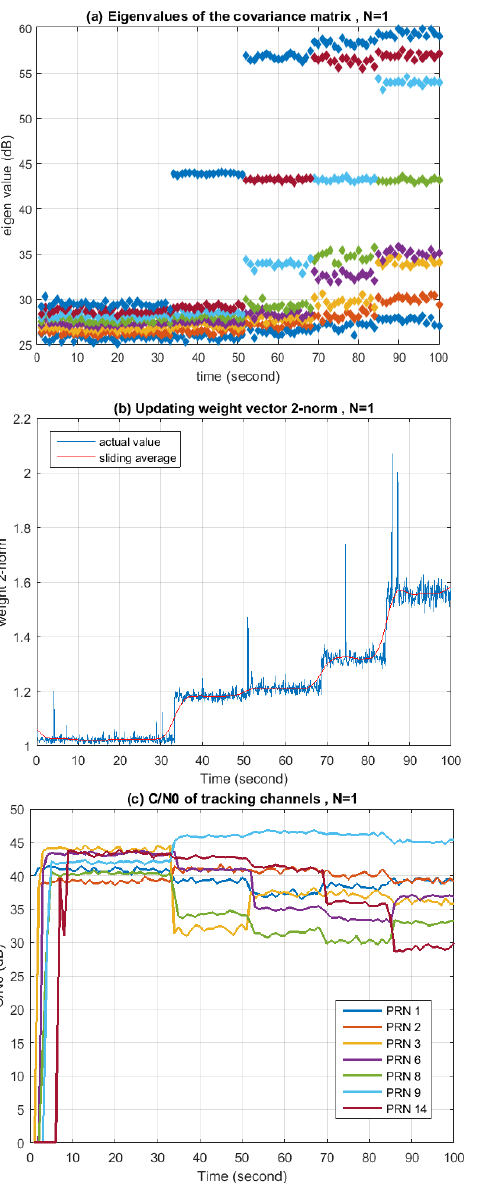
Figure 20. Performance of the STAP nulling during Jamming Scenario 2. ( a ) Eigenvalues of the corvariance matrix when N is 1; ( b ) 2-norm of the updating weight vector when N is 1; ( c ) C/N0 of the tracking channels when N is 1; ( d ) Eigenvalues of the corvariance matrix when N is 6; ( e ) 2-norm of the updating weight vector when N is 6; ( f ) C/N0 of the tracking channels when N is 6.